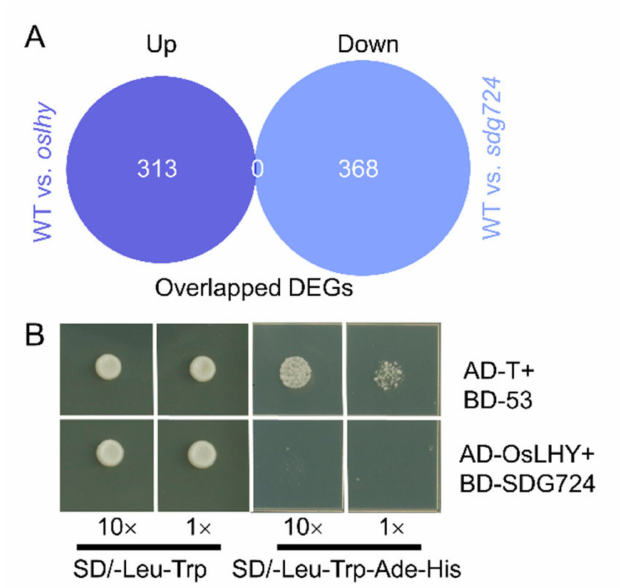
Figure 5. No physical interaction between OsLHY and SDG724 proteins. ( A ) Overlap analysis between upregulated DEGs of WT vs. oslhy and downregulated DEGs of WT vs. sdg724 . Up indicates the upregulated DEGs; down indicates the downregulated DEGs. ( B ) Yeast two-hybrid assays (Y 2 H) showed that OsLHY could not interact with SDG724. Co-transformation of AD-T and BD-5 was used as the positive